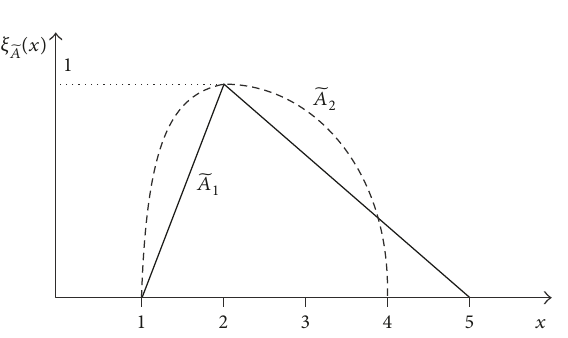
̃𝐴 ̃𝐴 1 and 2 in Example 22.